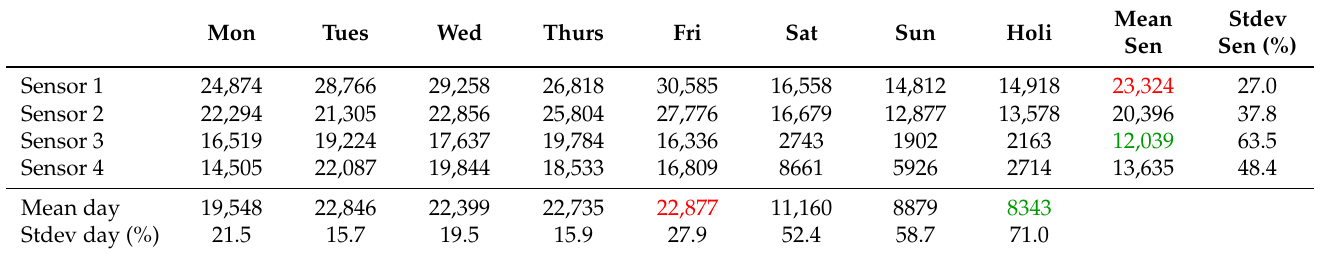
Table 3. Average number of devices sensed per day grouped by sensor id and type of day. The maximum and minimum mean values are marked in red and green,